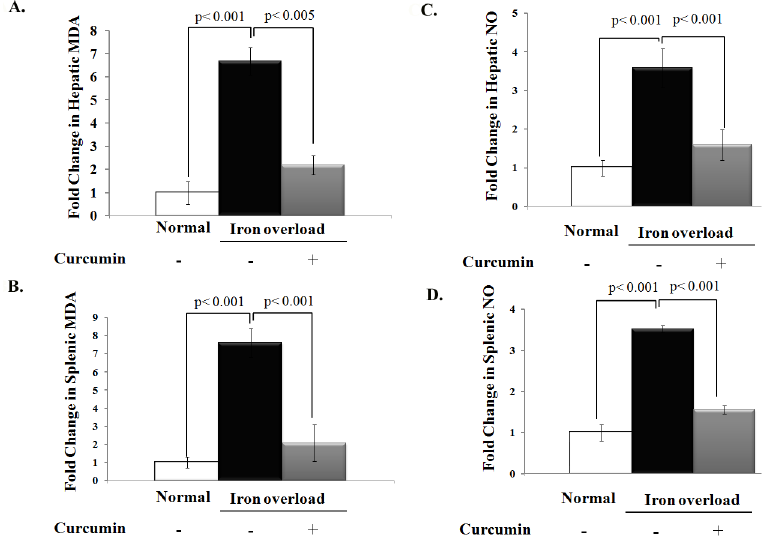
Fig 2. Effect of iron overloading on oxidative stress and NO levels in liver and spleen and potential protective effect of curcumin. A, B) Fold change in the level of malonyldialdehyde (MDA) as a marker of oxidative stress in liver and spleen (nmole/ g wet tissue), respectively, relative to that of normal control, which was assigned a value of 1. Levels of MDA in liver and spleen were significantly increased in iron overloaded rats relative to normal controls and curcumin treatment significantly decreased MDA levels in these tissues during iron overload. C, D) Fold change in the level of NO (nmole/ g wet tissue) in liver and spleen tissues, respectively, relative to that of normal control. Levels of NO in these tissues were significantly increased in iron overloaded rats than in control rats and was significantly reduced by curcumin treatment in iron overloaded rats. Data shown are the mean ± SD (n =